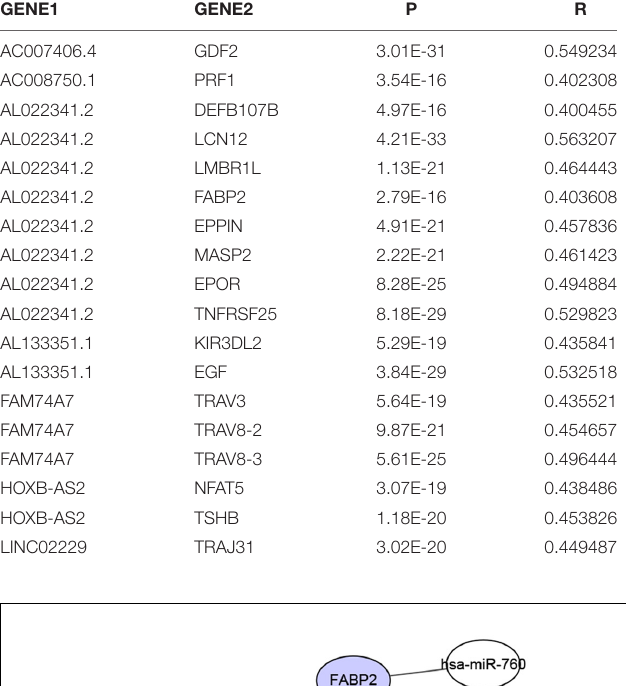
TABLE 3 | The seven immune-related lncRNAs and 18 corresponding immune-related genes.